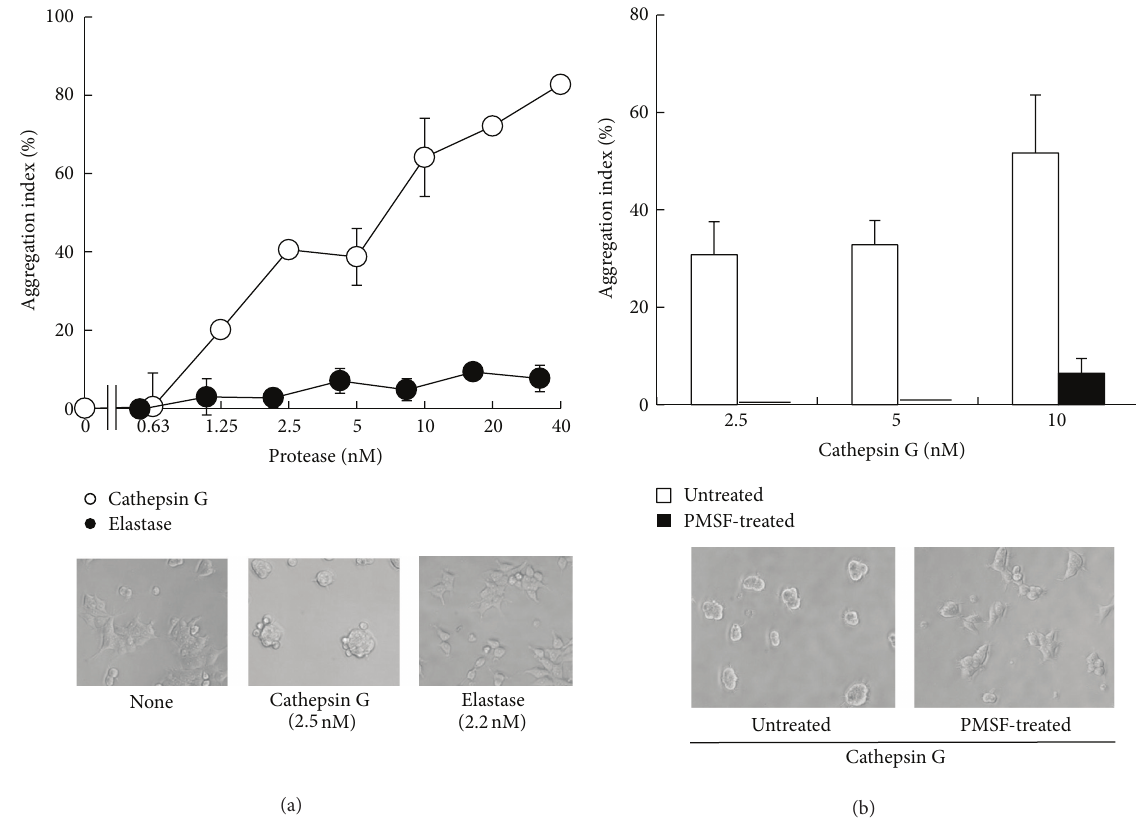
Figure 6: Induction of MCF-7 cell aggregation by cathepsin G, but not elastase, treatment of PLL-coated wells. (a) PLL-coated wells were treated overnight with cathepsin G ( I ) or elastase ( e ). After the enzymes were removed by washing, MCF-7 cells suspended in 1% BSA- medium were seeded and incubated for an additional 24 h. The cell aggregation index was evaluated as described in the legend of Figure 2. The results are expressed as the mean ± SD ( 𝑛 = 3 ). When the bars are not shown, they are smaller than the size of the symbols. Original magnification: × 100. (b) PLL-coated wells were treated overnight with cathepsin G for 24 h, and then the wells were washed and treated without (open column) or with PMSF (4mM, filled column) at 37 ∘ C for 1h. MCF-7 cells suspended in 1% BSA-medium were then seeded and incubated for an additional 24h. Cell aggregation was evaluated as above. Lower photos: images of MCF-7 cells at 24h after cultivation in the cathepsin G (2.5 nM)-treated PLL-coated wells, subsequently treated without (left) or with (right)